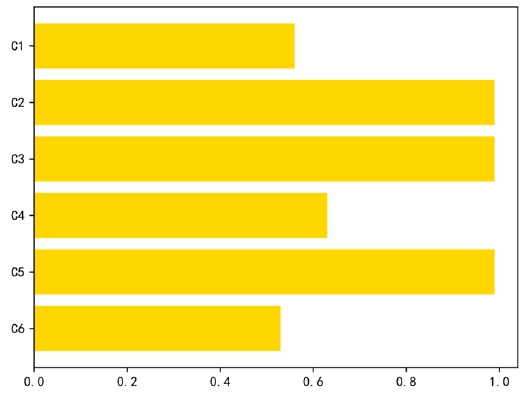
Figure 13. Bidding capacity ratio of individual generators.